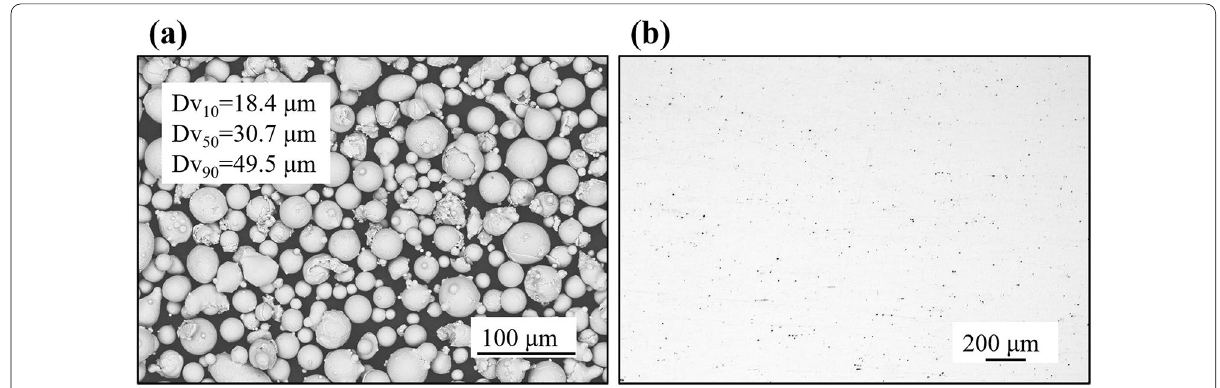
Figure 3 ( a ) Morphology and particle size of Inconel 738LC alloy powders, ( b ) polished Inconel 738LC alloy sample with micro defects